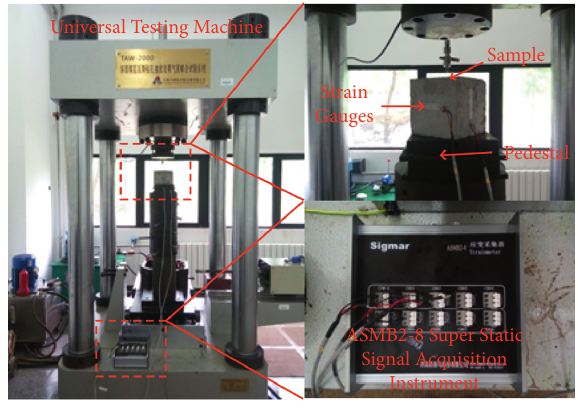
Figure 2: Test instrument